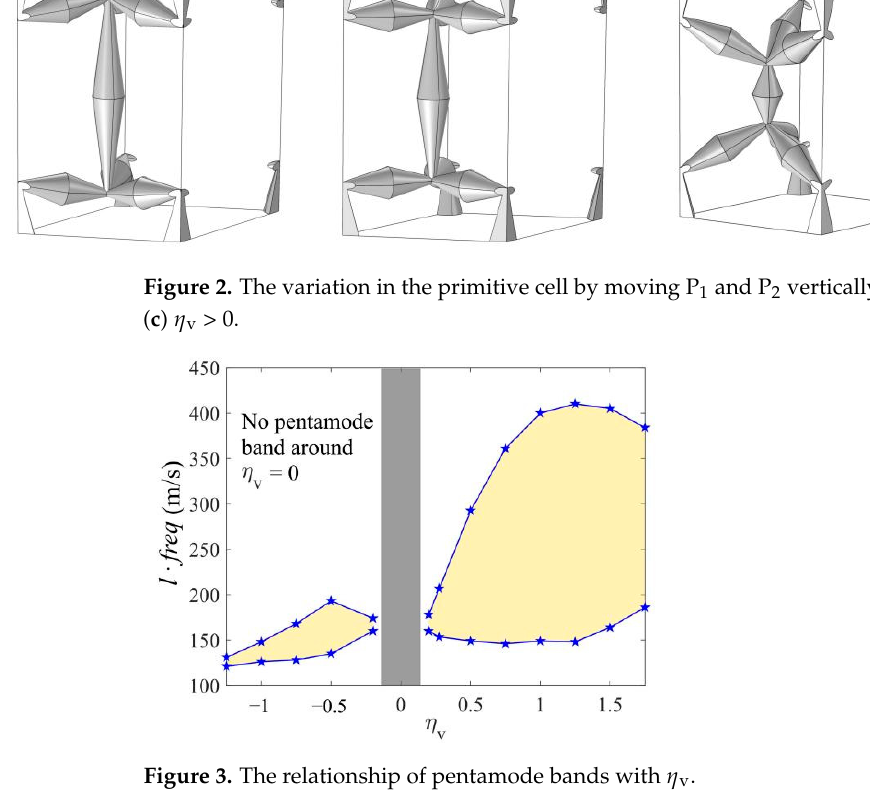
Figure 3. The relationship of pentamode bands with η v .